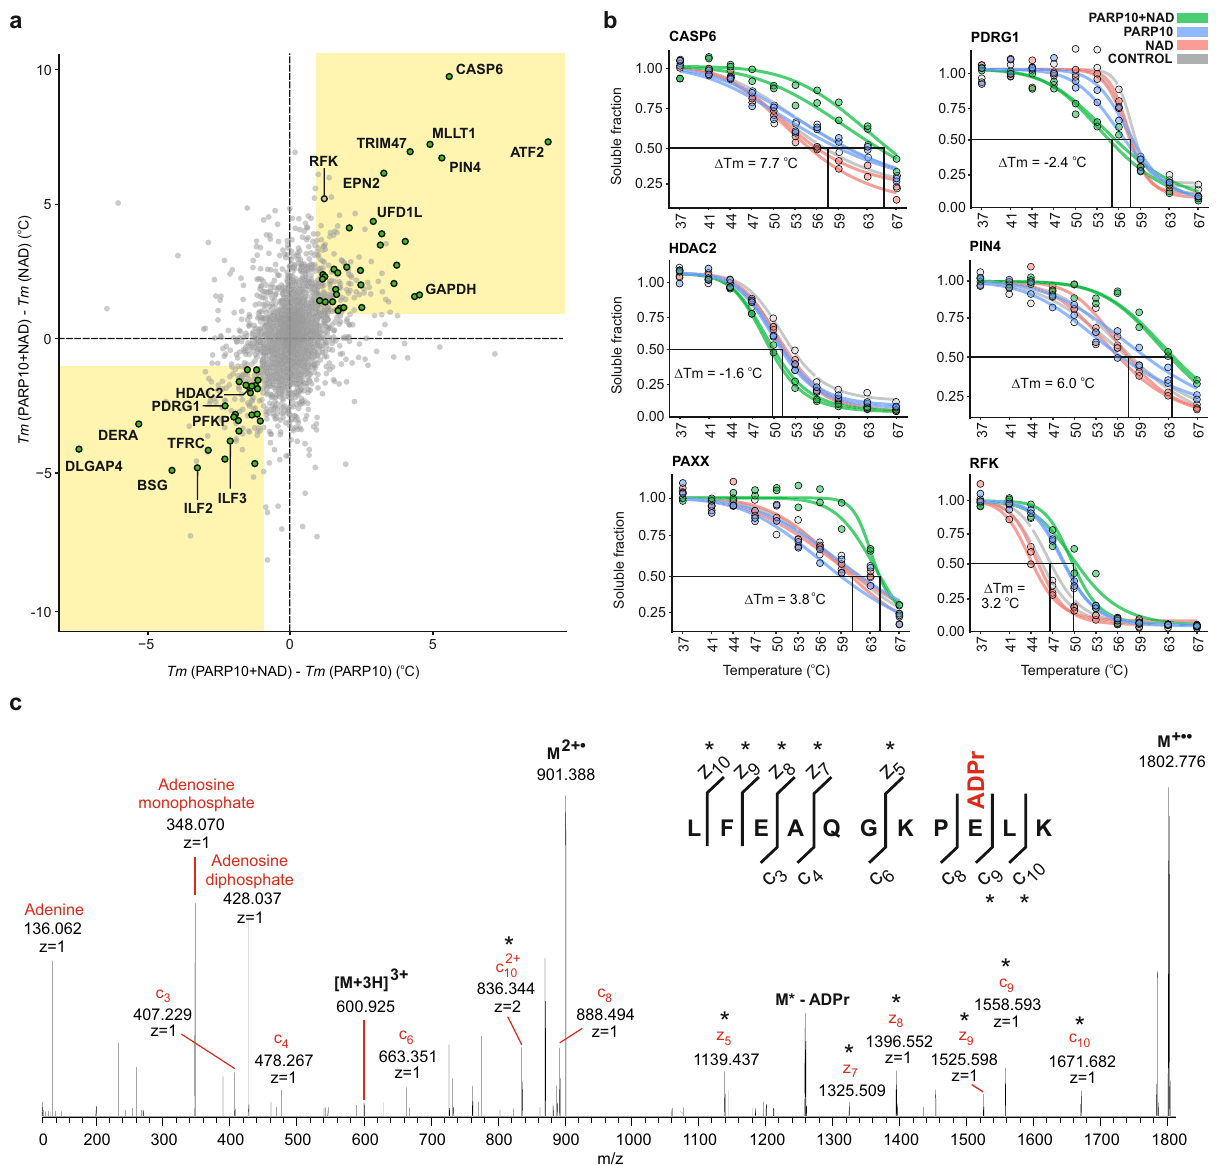
Fig. 4 SIESTA identi fi ed and ranked known and novel PARP10 substrates. a Scatterplot of T m differences reveals the shifts occurring when PARP10 + NAD are incubated with cell lysate. Known and putative substrates are shown in green circles. b Representative melting curves of putative PARP10 substrates. c Mono-ADP-ribosylation on a glutamic acid residue Glu110 in the PDRG1 peptide with the highest sequence- fi tting score revealed by targeted ETD MS/MS of 3 + molecular ions (M). The fragments carrying the modi fi cation are marked with an asterisk ( Tm melting temperature, NAD nicotinamide adenine dinucleotide, PARP10 poly-(ADP-ribose) polymerase-10). Source data are provided as a Source Data fi